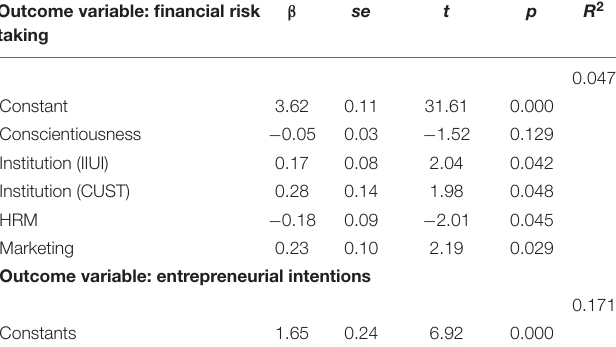
TABLE 7 | Mediating role of financial risk taking between agreeableness and entrepreneurial intentions. Financial risk